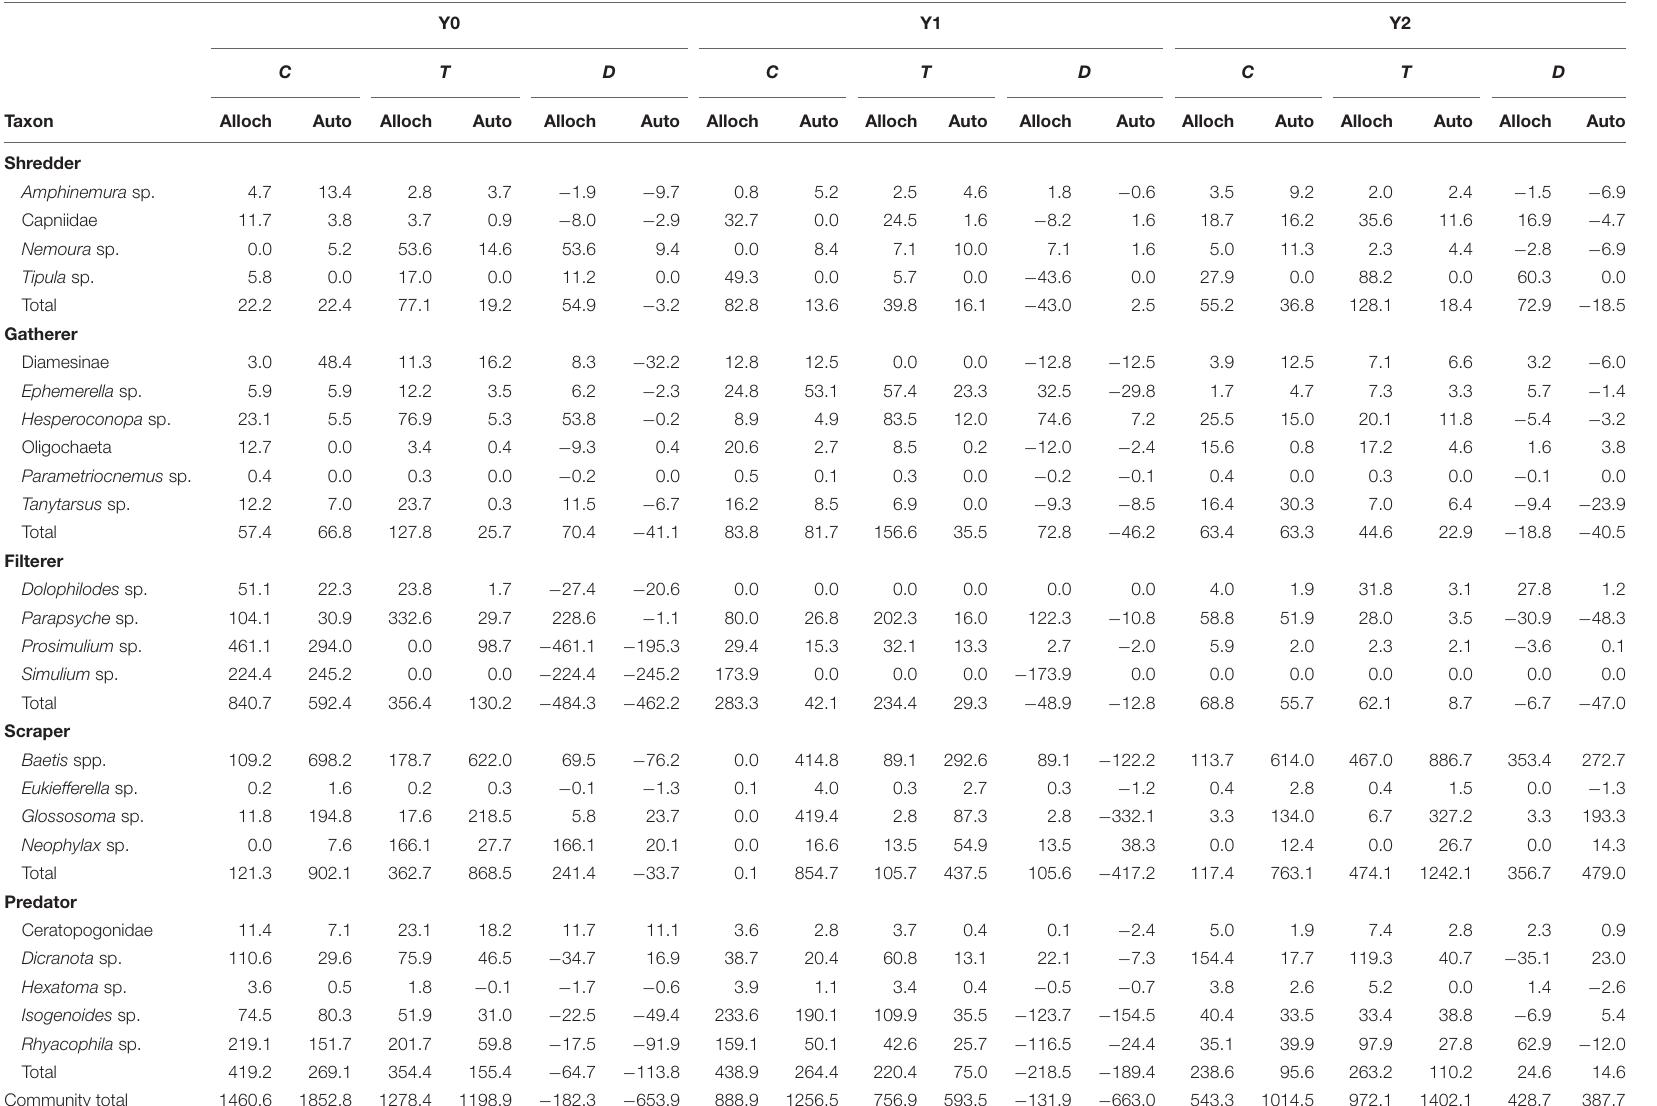
*Indicates a significant change in mean macroinvertebrate δ 13 C value after wood addition. D is the difference in treatment (T) and control (C). B is before (Y0) and A. is after (Y1 and Y2) wood addition. Functional groups are in